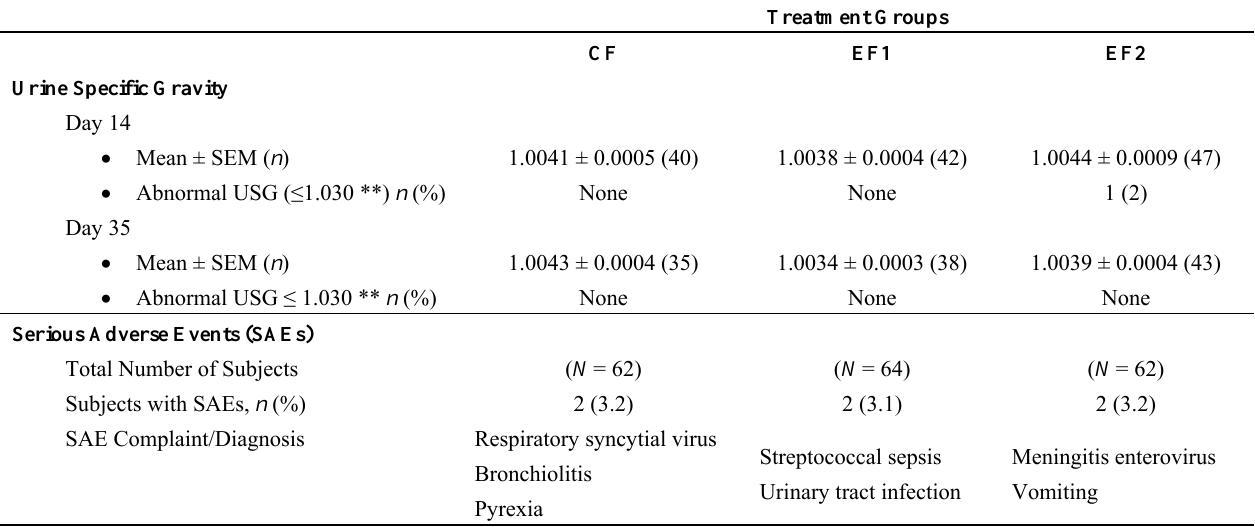
Table 6. Urine specific gravity and serious adverse events for study subjects